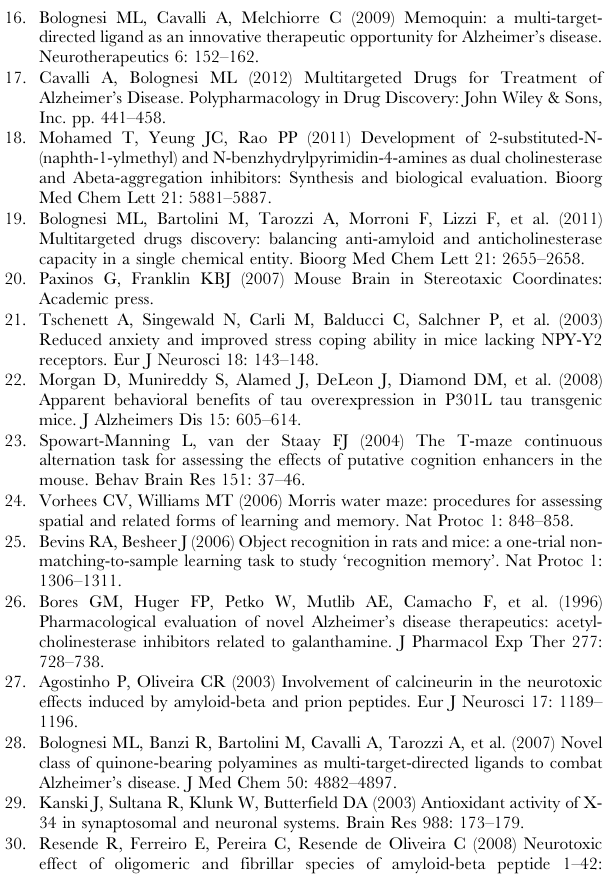
Figure S1 2D structure of the multi-target compound, Memoquin. Figure S2 MQ does not alter motor activity. Effect of MQ treatment on distance traveled in an open field (A) and on motor coordination in the accelerating rotarod task (B) in mice. MQ (7– 15 mg/kg, p.o.) was administered 40 min before testing. Data are expressed as mean 6 S.E.M. No significant differences were found (One-way ANOVA).